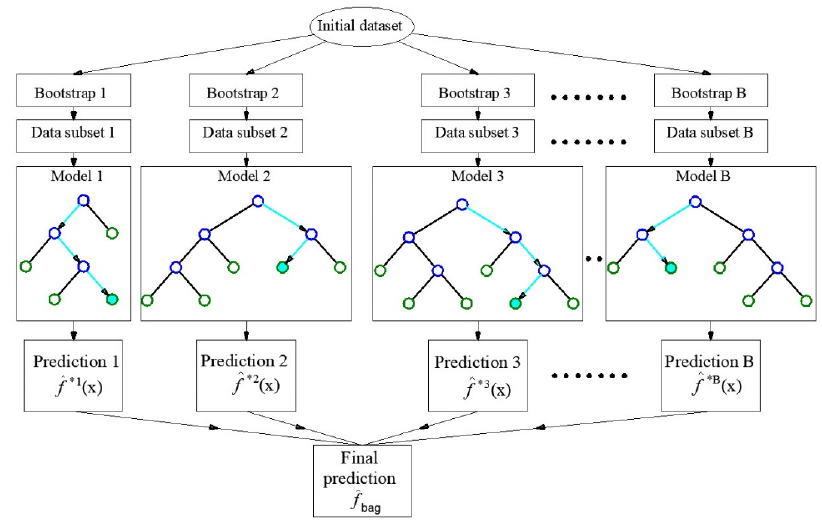
Figure 3. Creation of an ensemble composed of individual regression trees [2].